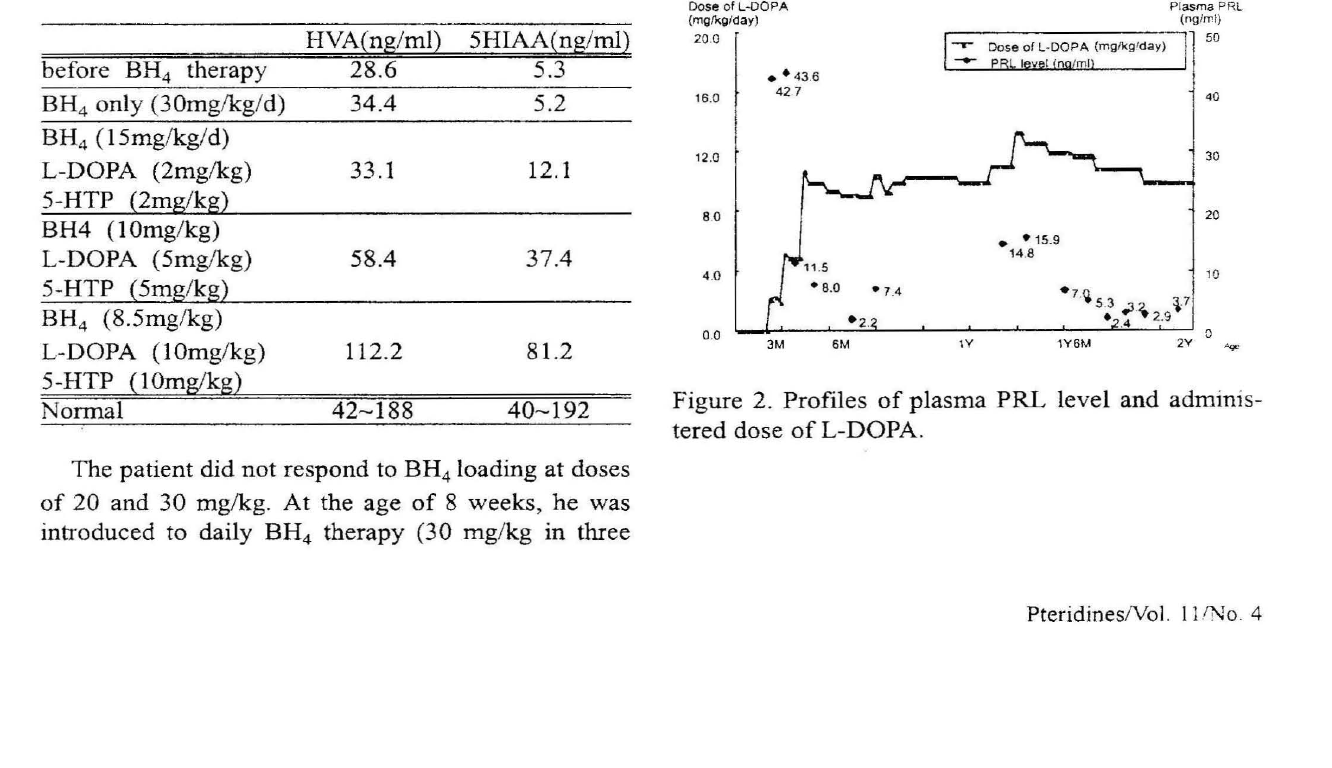
induced. With the oral therapy of L-DOPA and 5-HTP (10 mg/kg/d.), his CSF concentrations of HVA and 5HlAA increased (Table 4). The role of dopamine as a prolactin-inhibiting factor on both the pituitary and hypothalamic level was established. The patient's CSF HVA concentration increased after L-DOPA therapy, and his serum prolactine level decreased (Figure 2).